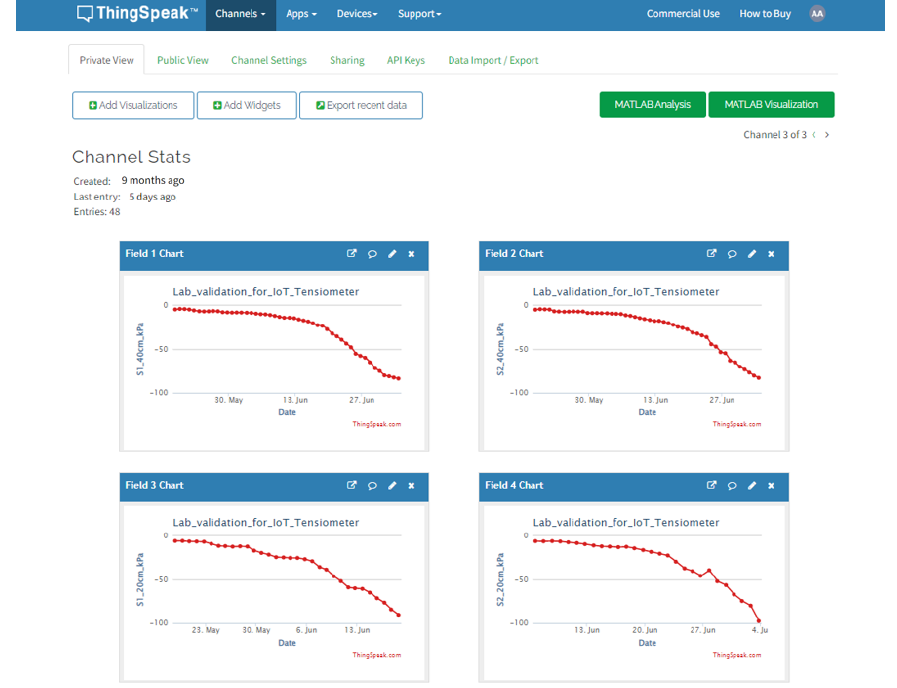
Figure 5. Online soil water potential curve from ThingSpeak.